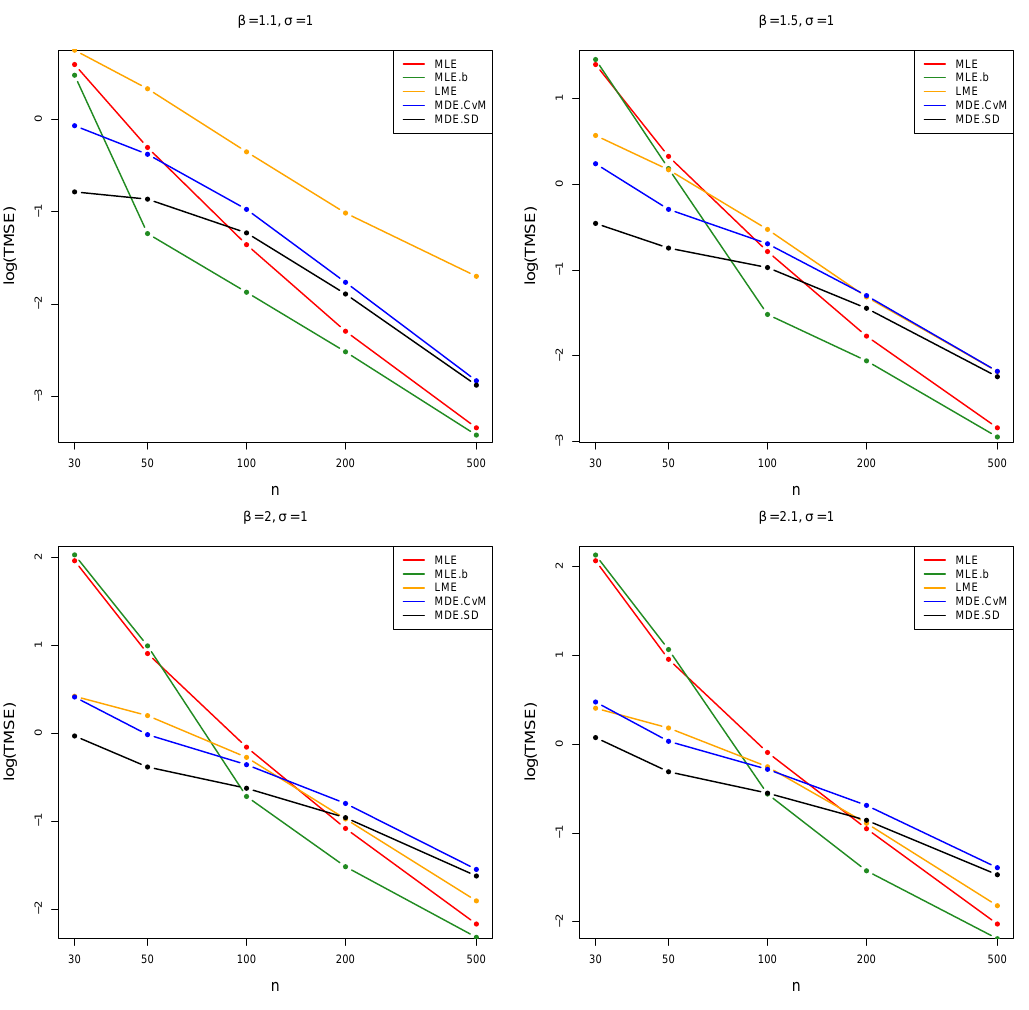
Figure 1. Plots of the log of the trimmed TMSE measure against sample size for five different estimation techniques when σ =